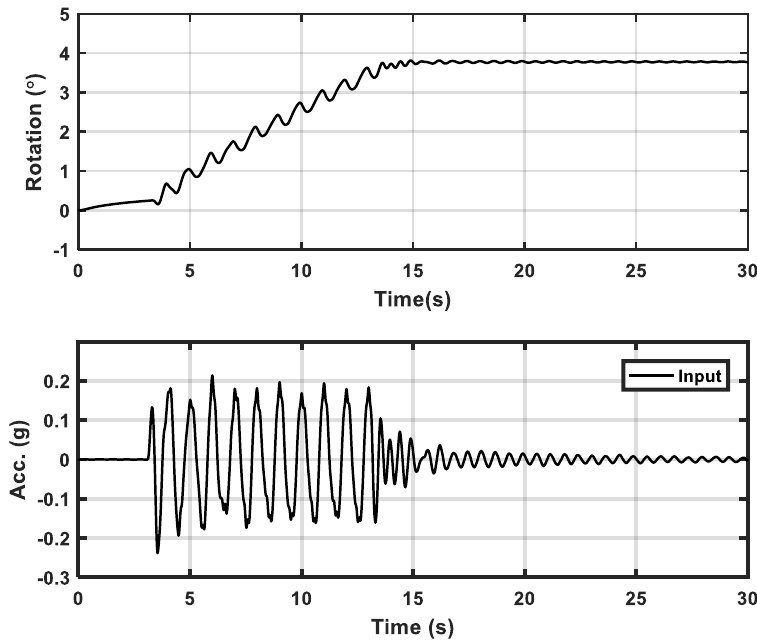
Figure 15. Rotation of the structure due to a sinusoidal input motion.